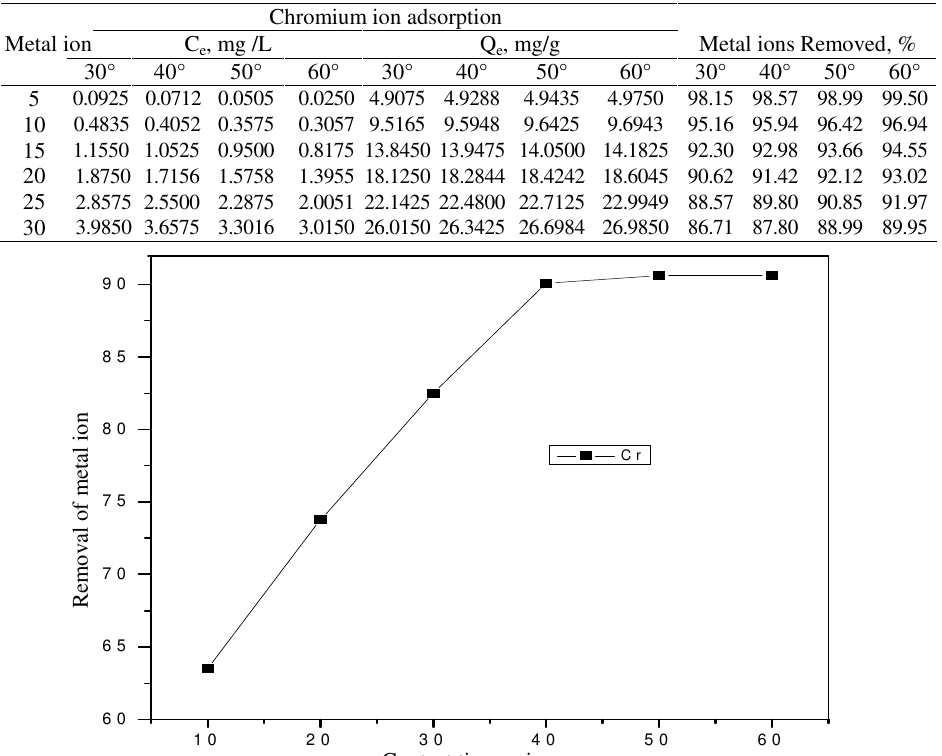
Table 1. Equilibrium Parameters for the adsorption metal ion onto BBC.